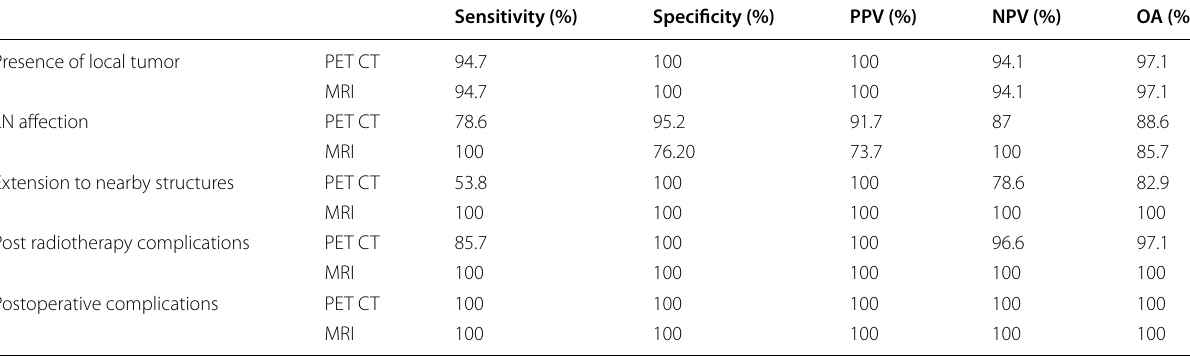
PPV positive predictive value, NPV negative predictive value, OA overall